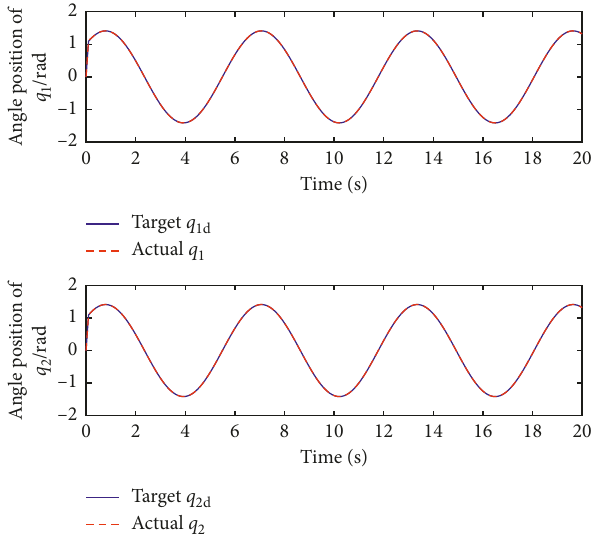
Figure 4: Tracking performance of q based